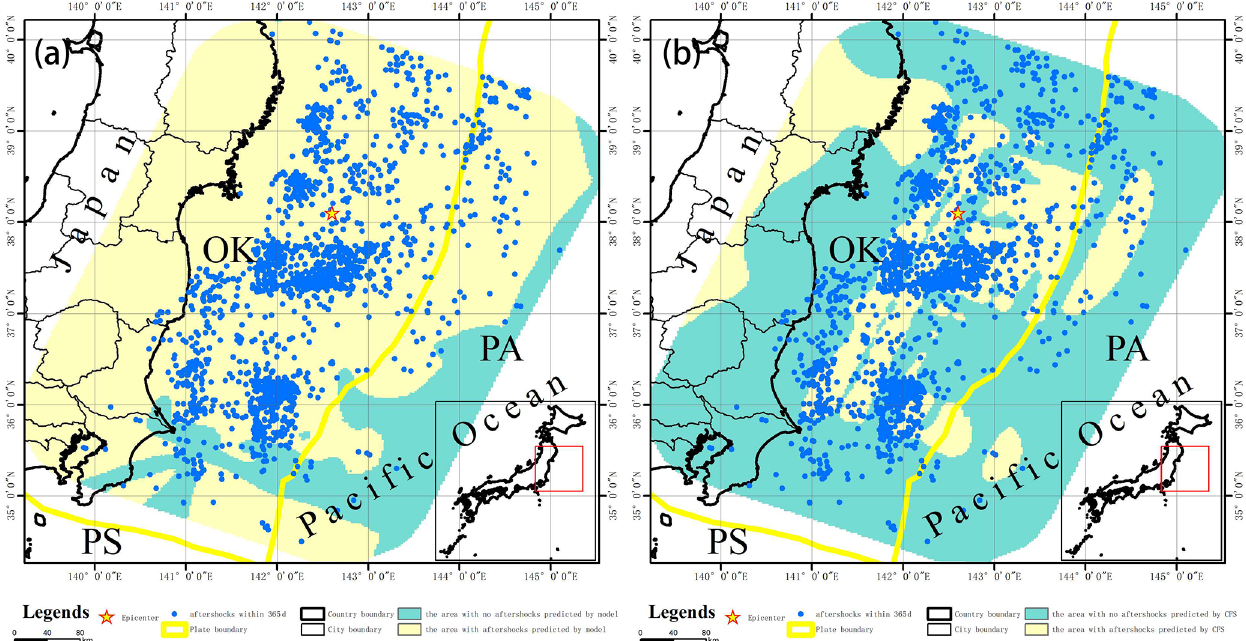
Figure 18. The hysteresis model prediction result and the (cid:49) CFS prediction result of the Tohoku earthquake. Panel (a) shows the hysteresis model prediction result, and panel (b) shows the (cid:49) CFS prediction